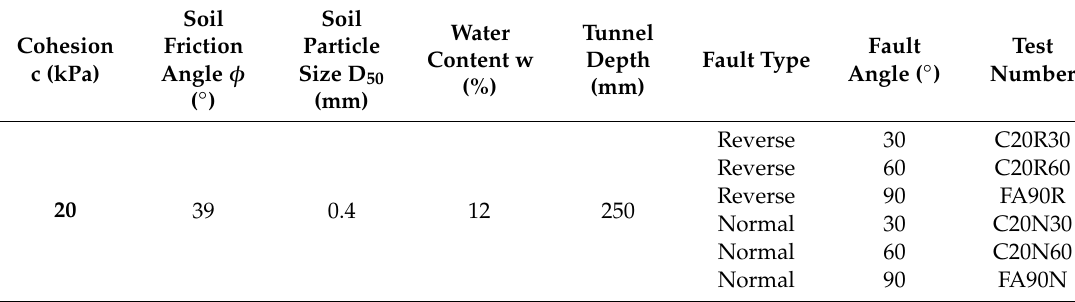
Table 6. Soil properties used for fault angles.